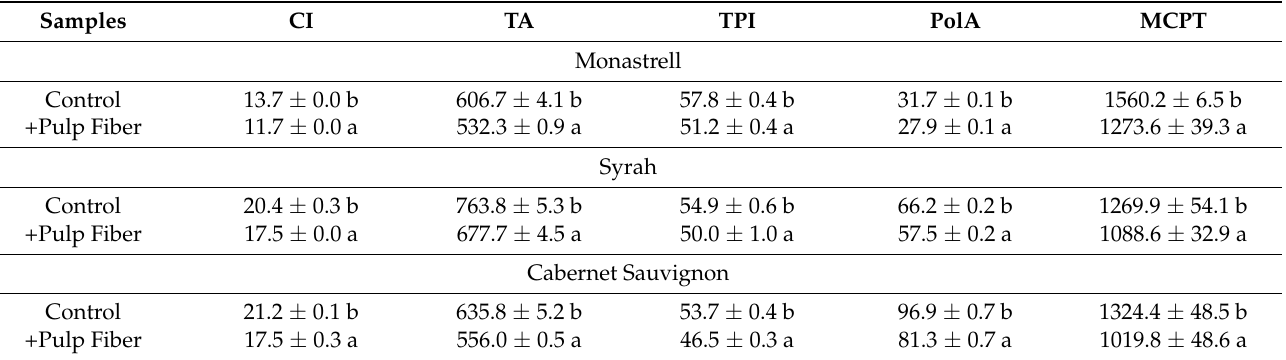
Table 2. Chromatic characteristics of the wines with and without treatment with the fining agent (pulp